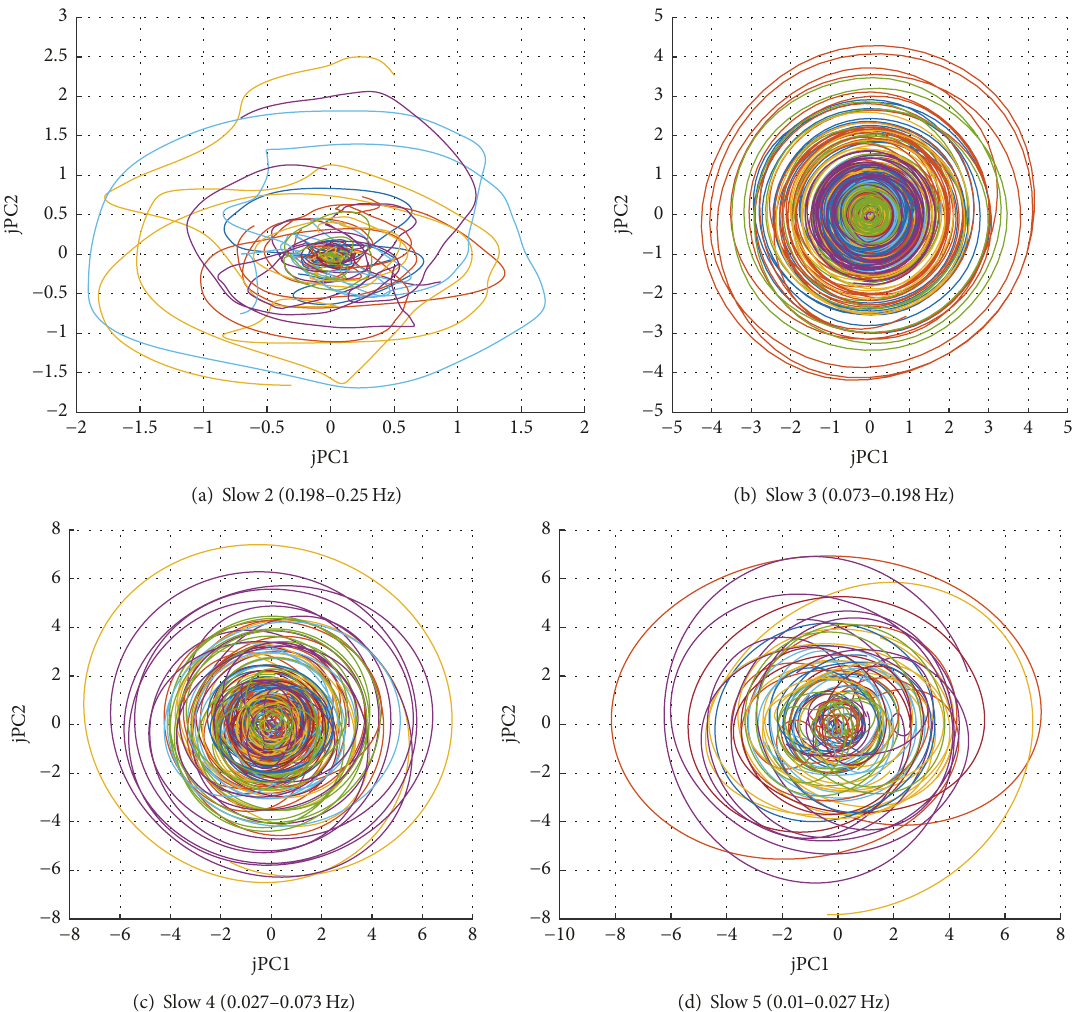
Figure 3: BOLD trajectories after projection with jPCA (one color represents one person of the elderly group; all trajectories were obtained with cubic spline interpolation).